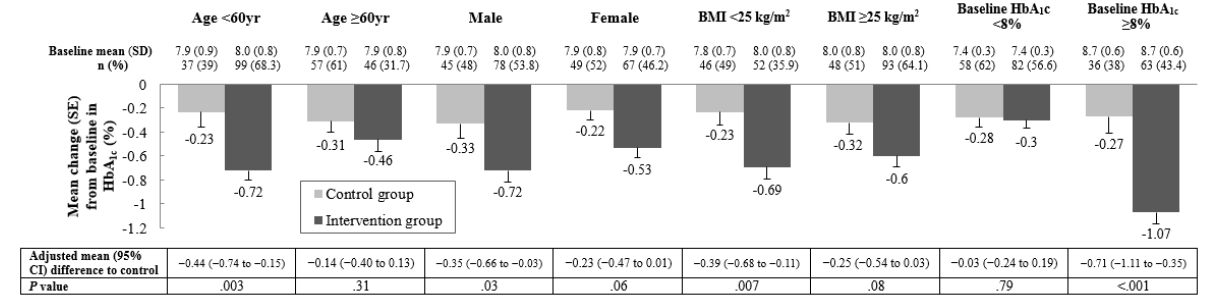
Figure 2. Subgroup analyses of changes in glycemic status by age, sex, BMI, and baseline hemoglobin A 1c (HbA 1c ). Baseline data are expressed as mean (SD), and mean change of outcomes are expressed as mean (SE). The gray and black bars represent the control and intervention groups,